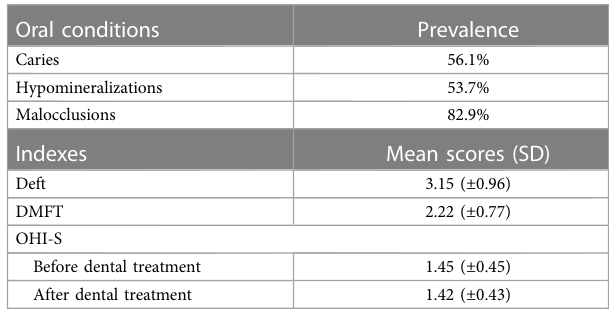
TABLE 2 Oral conditions in the studied